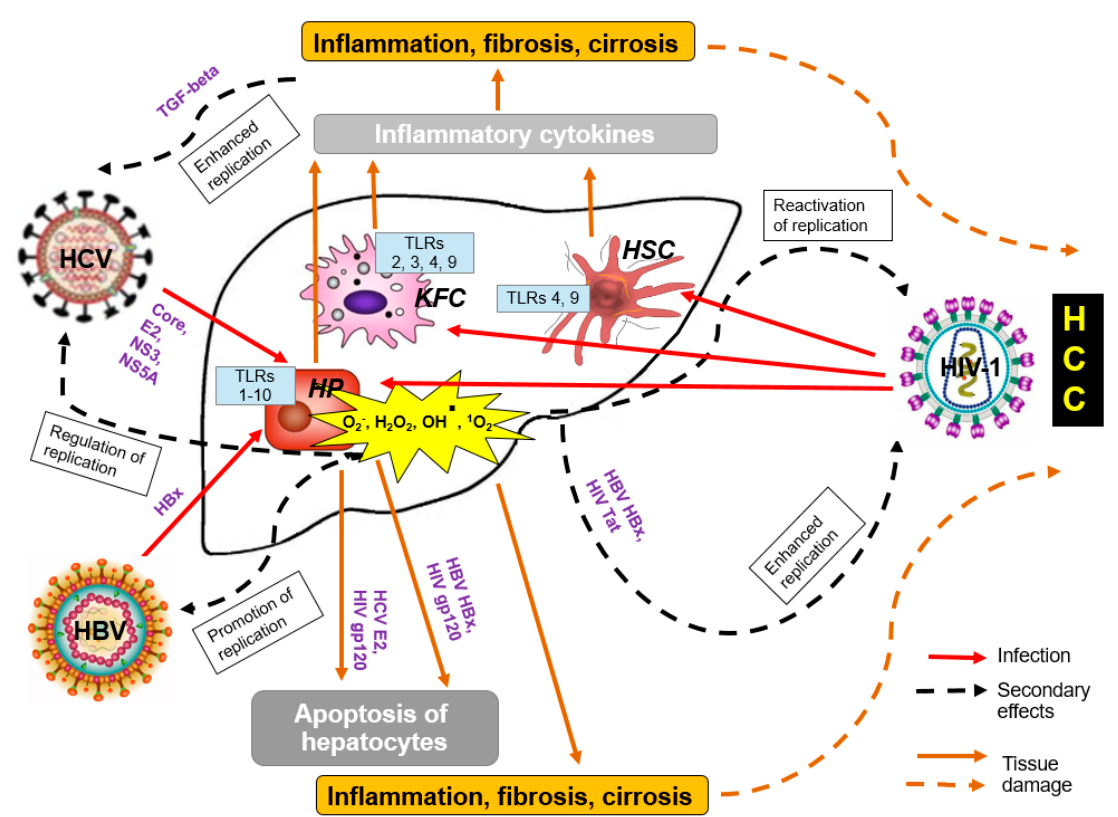
Figure 1. The effect of HIV-1 on cells of the liver. Infection with HIV-1 and even exposition of hepatocytes (HP), hepatic stellate cells (HSC), Kupffer cells (KFC) to HIV-1 leads to production of reactive oxygen species (ROS) and induction of proinflammatory microenvironment, which in turn, promote/enhance replication of HBV, HCV, as well as HIV-1 itself, resulting in enhanced fibrosis, cirrhosis and development of hepatocellular carcinoma (HCC). Infections are depicted in red, secondary effects in dashed black, and events leading to tissue damage in ochre-colored lines.